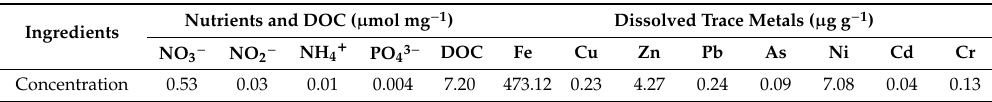
Table 1. Concentrations of nutrients, Dissolved organic carbon (DOC), dissolved trace metals in the sand-dust.